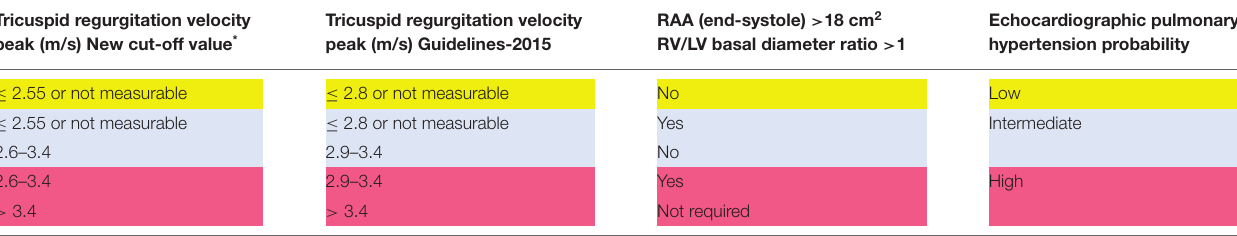
TABLE 1 | Echocardiographic probability of pulmonary hypertension according to current ESC/ERS guidelines and the new cut-off point. Tricuspid regurgitation velocity peak (m/s) New cut-off value